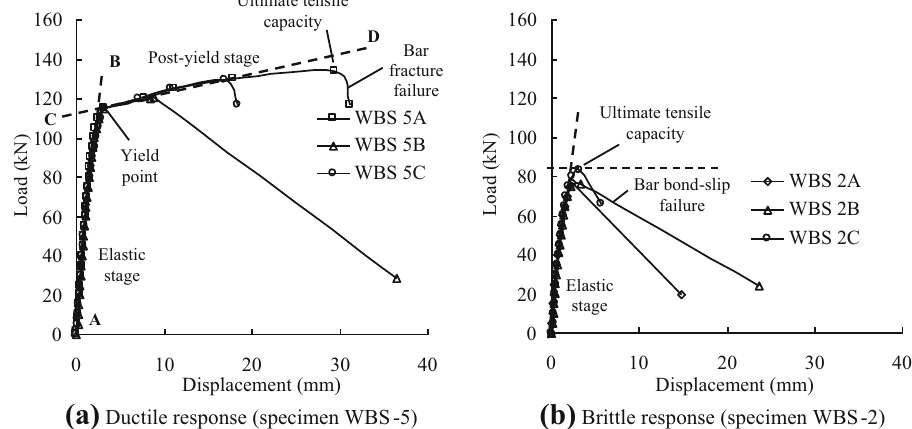
Fig. 8 Load-displacement response under tensile load